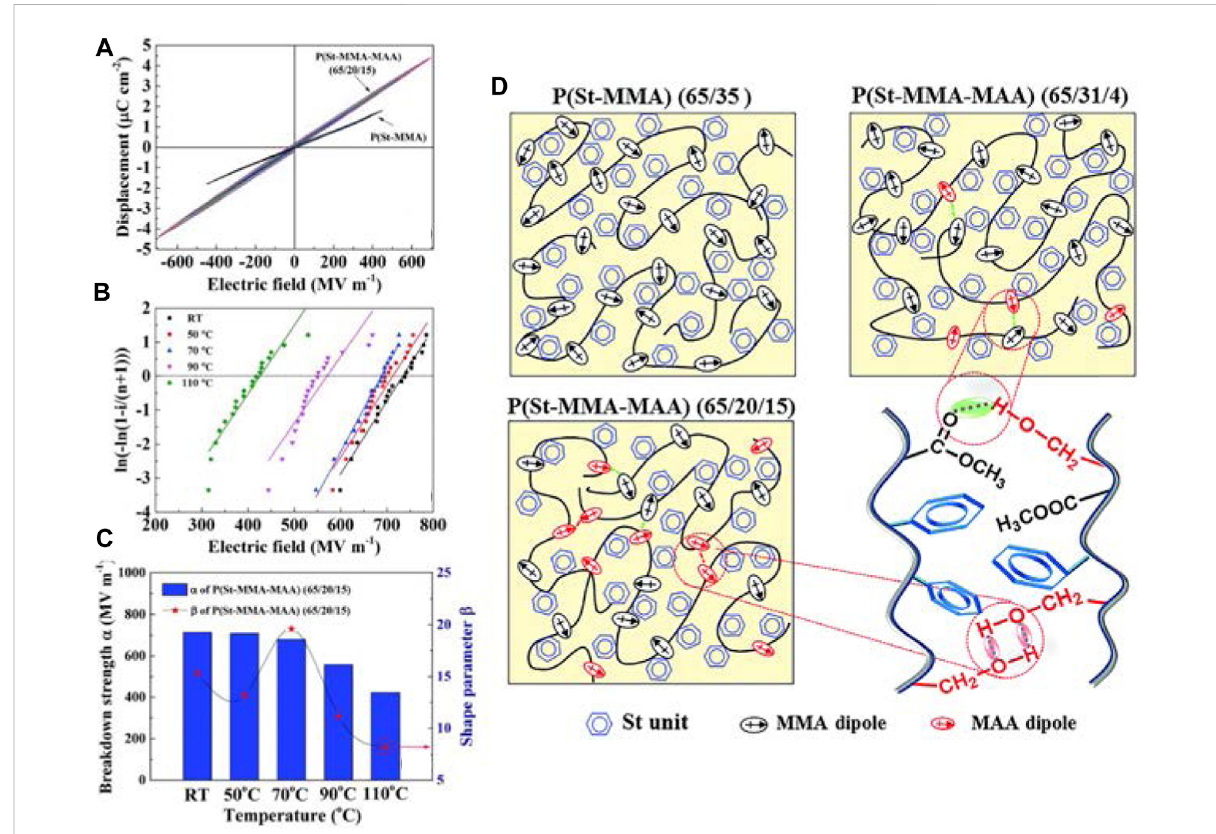
FIGURE 12 (A) D - E loops of P(St-MMA) and P(St-MMA-MAA)(65/20/15) at room temperature, (B) E b and (C) the Weibull distribution of P(St-MMAMAA) (65/ 20/15) at elevated temperature, (D) Schematic models of the molecular morphology of P(St-MMA) and P(St-MMA-MAA)s. Reproduced with permission from Ref. 104. Copyright 2019 The Royal Society of